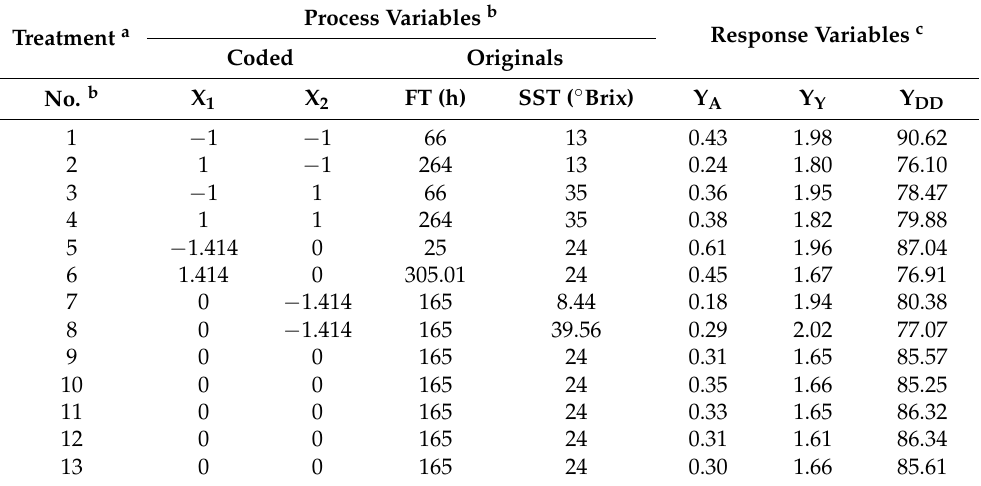
Table 1. Experimental design for chitosan optimization from lactic fermentation of shrimp waste. Treatment